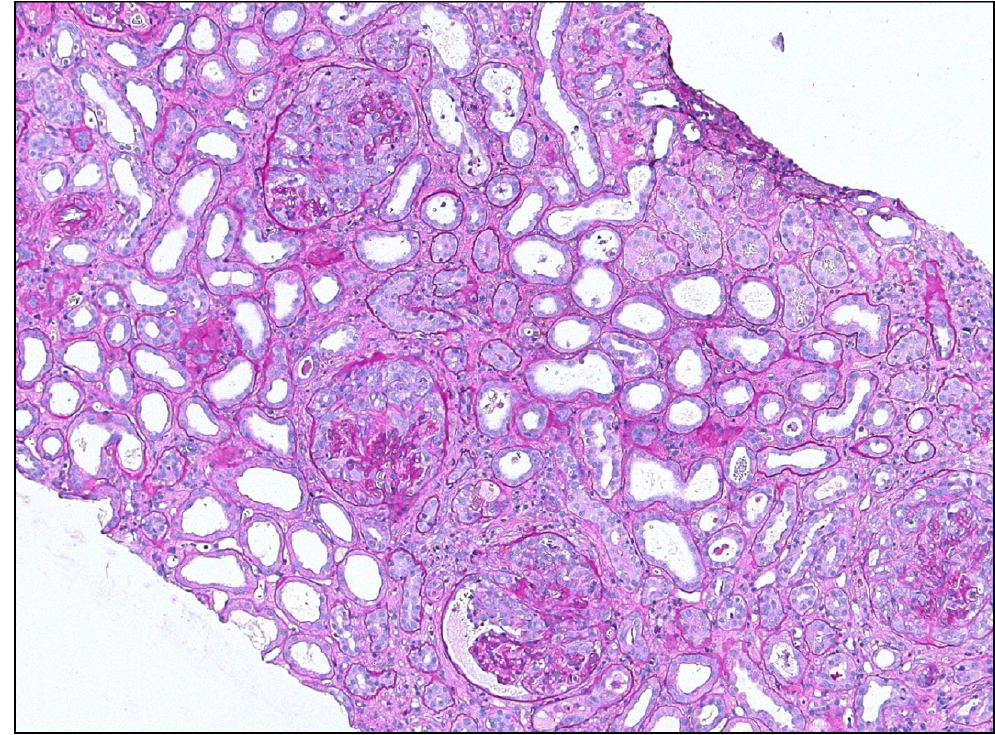
Figure 4. Overshooting epithelial regeneration in crescentic glomerulonephritis. Massive and uncoordinated proliferation of parietal epithelial cells leads to crescent formation